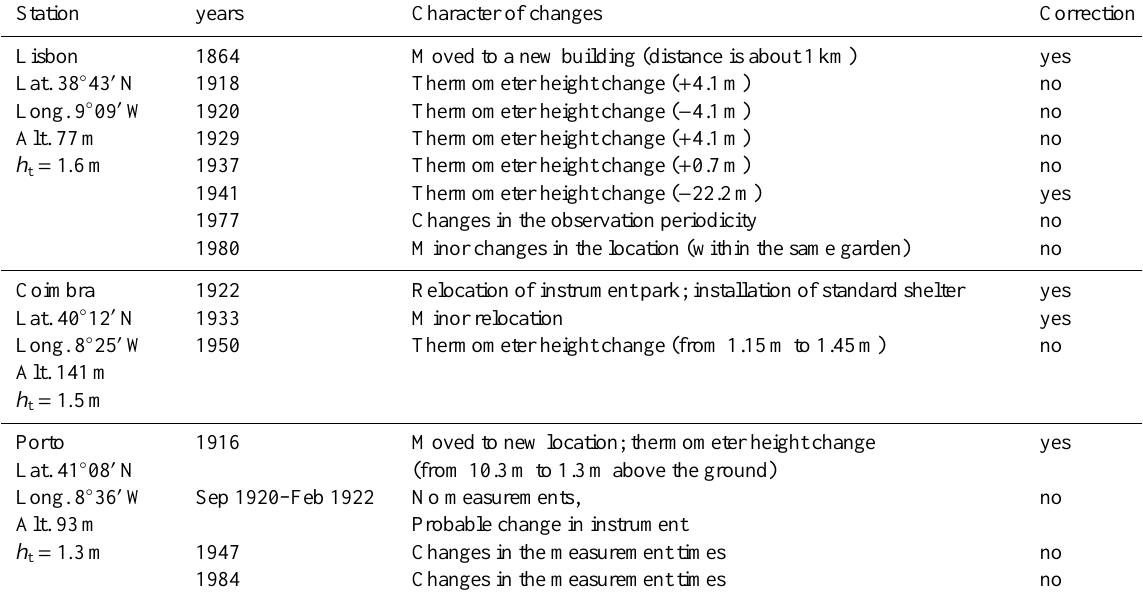
Table 3. Known dates of changes in thermometer heights ( h t ) and locations for the three Portuguese stations of Lisbon, Coimbra and Porto. Station years Character of changes Correction Lisbon 1864 Moved to a new building (distance is about 1km) yes Lat. 38 ◦ 43 0 N 1918 Thermometer height change ( + 4.1m) Thermometer height change ( − 4.1m) Thermometer height change ( + 4.1m)